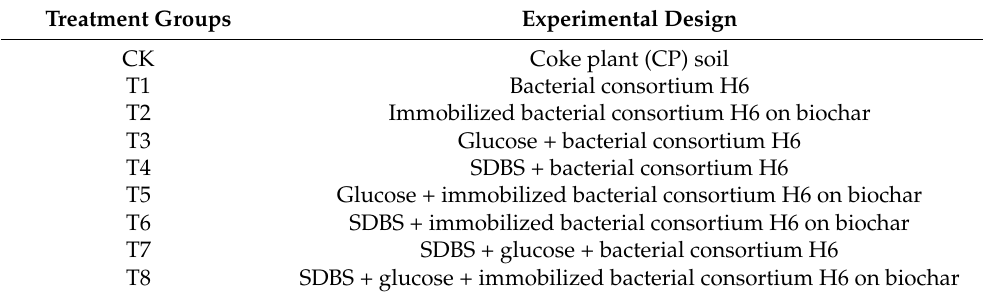
Table 1. Experimental design of bioremediation. Treatment